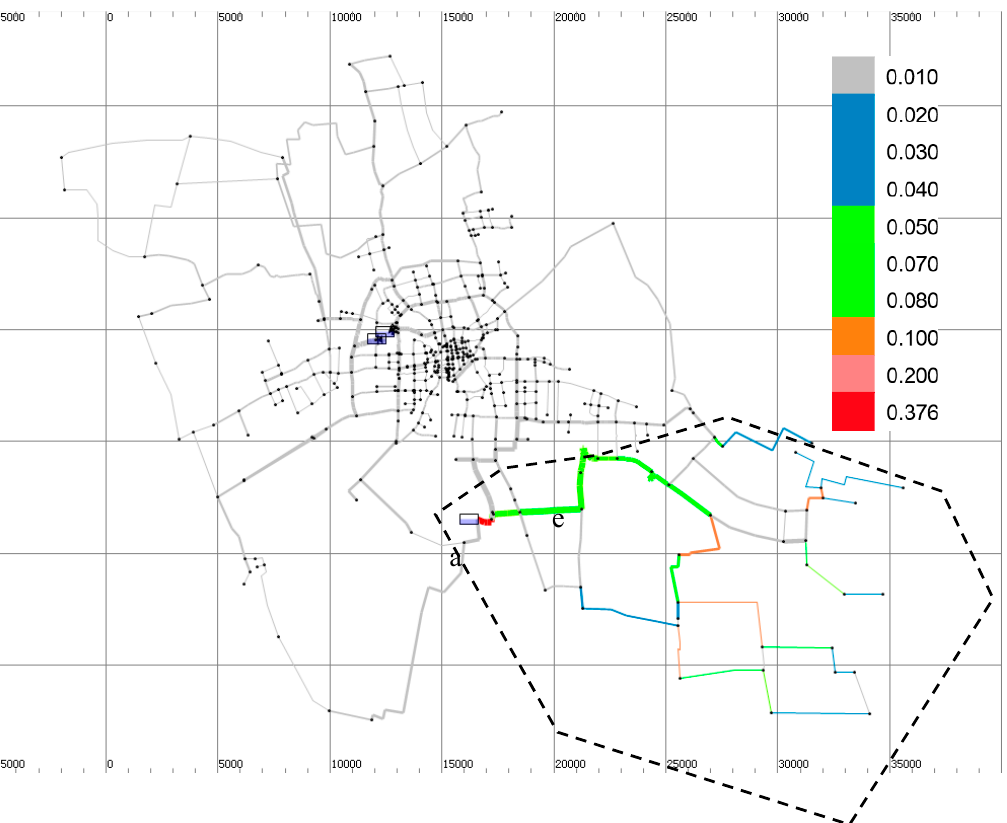
Figure 5. UIPF assessment in the southeast region of J